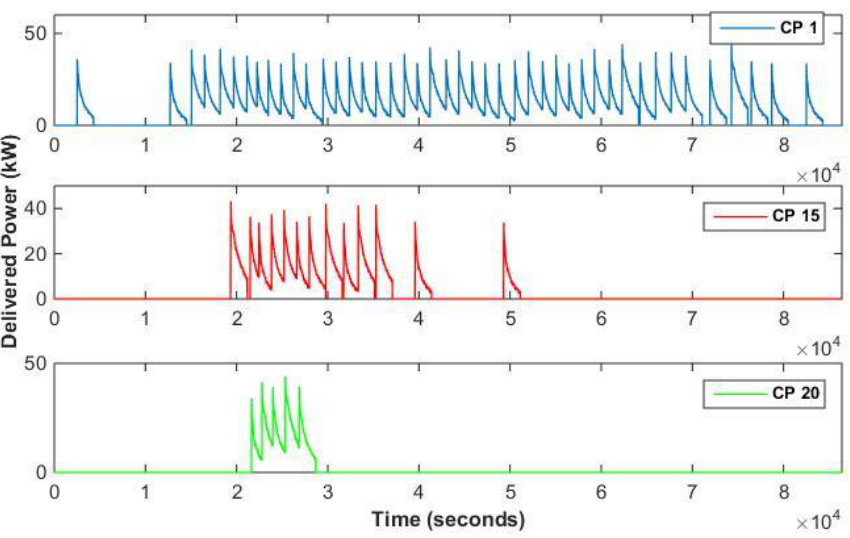
Figure 10. Charge profiles of CP 1, 15, and 20 of station 3 for scenario (0, 12, 20).